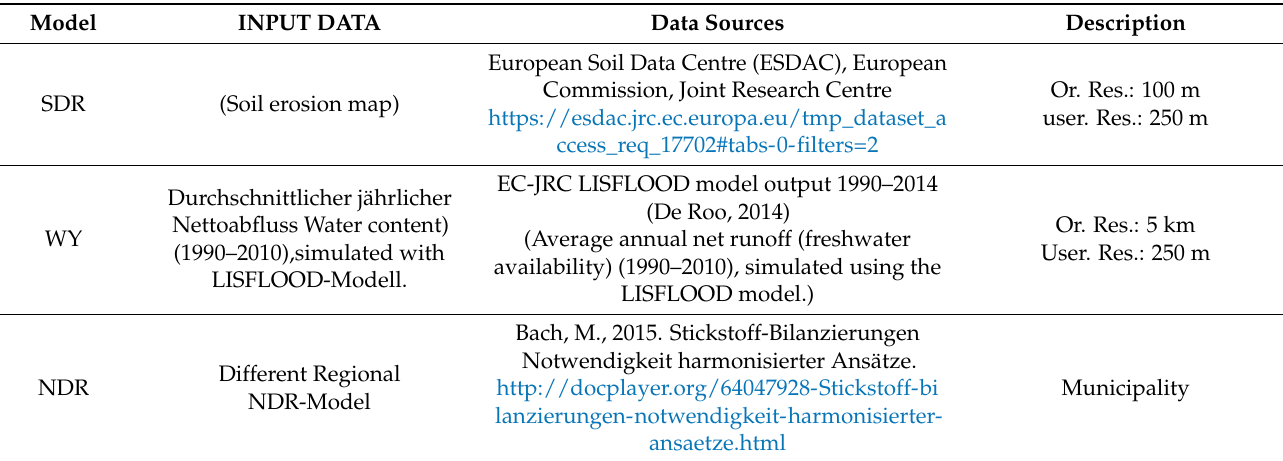
Table A2. Calibration data sources for